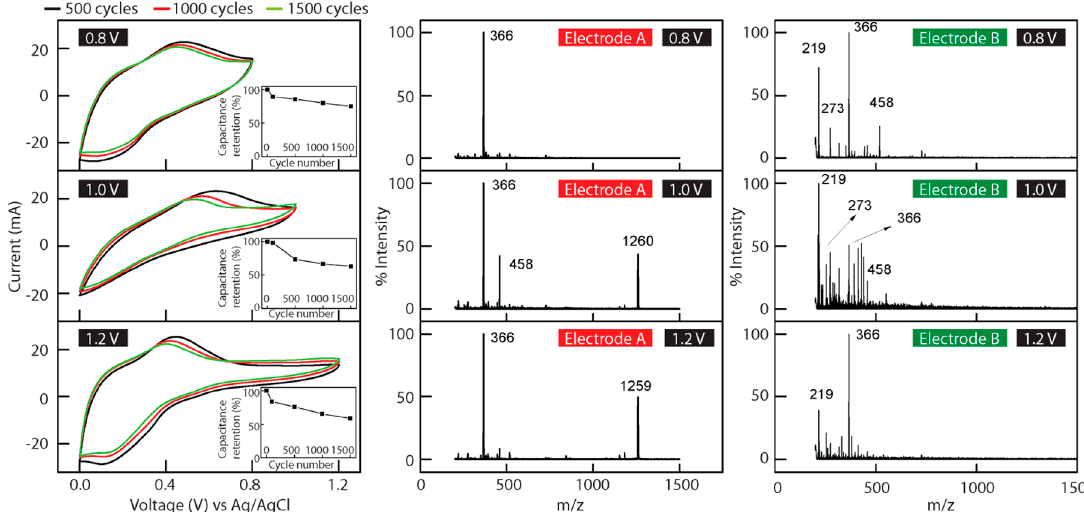
Figure 6. Select cyclic voltammetry spectra, taken throughout device cycling tests under different potential windows with their corresponding MALDI TOF spectra from electrodes A and B, showing peak polymerization and degradation after cycling. Inserts in the CV diagram plots show the percent capacitance retention as a function of cycle number.